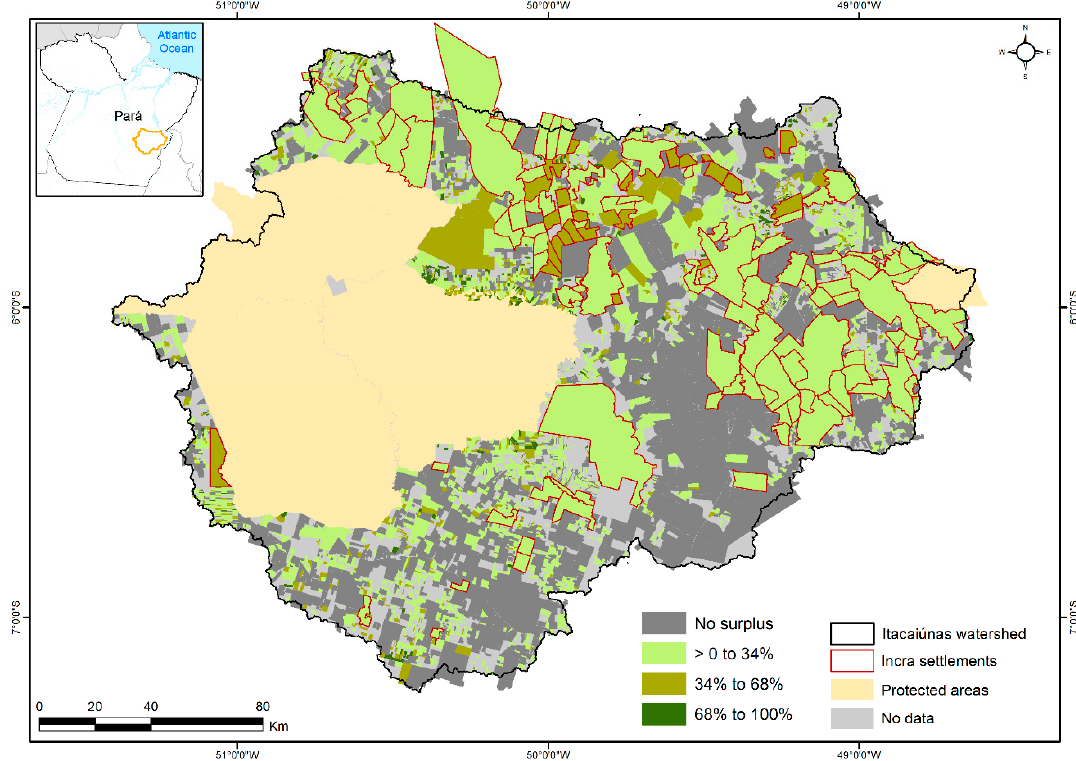
Figure 6. Legal reserve deficit and surplus estimates in rural properties registered under CAR and in Incra settlements, as defined by Brazilian environmental law (Law no. 12651, 25 March 2012), across the Itacaiúnas watershed.